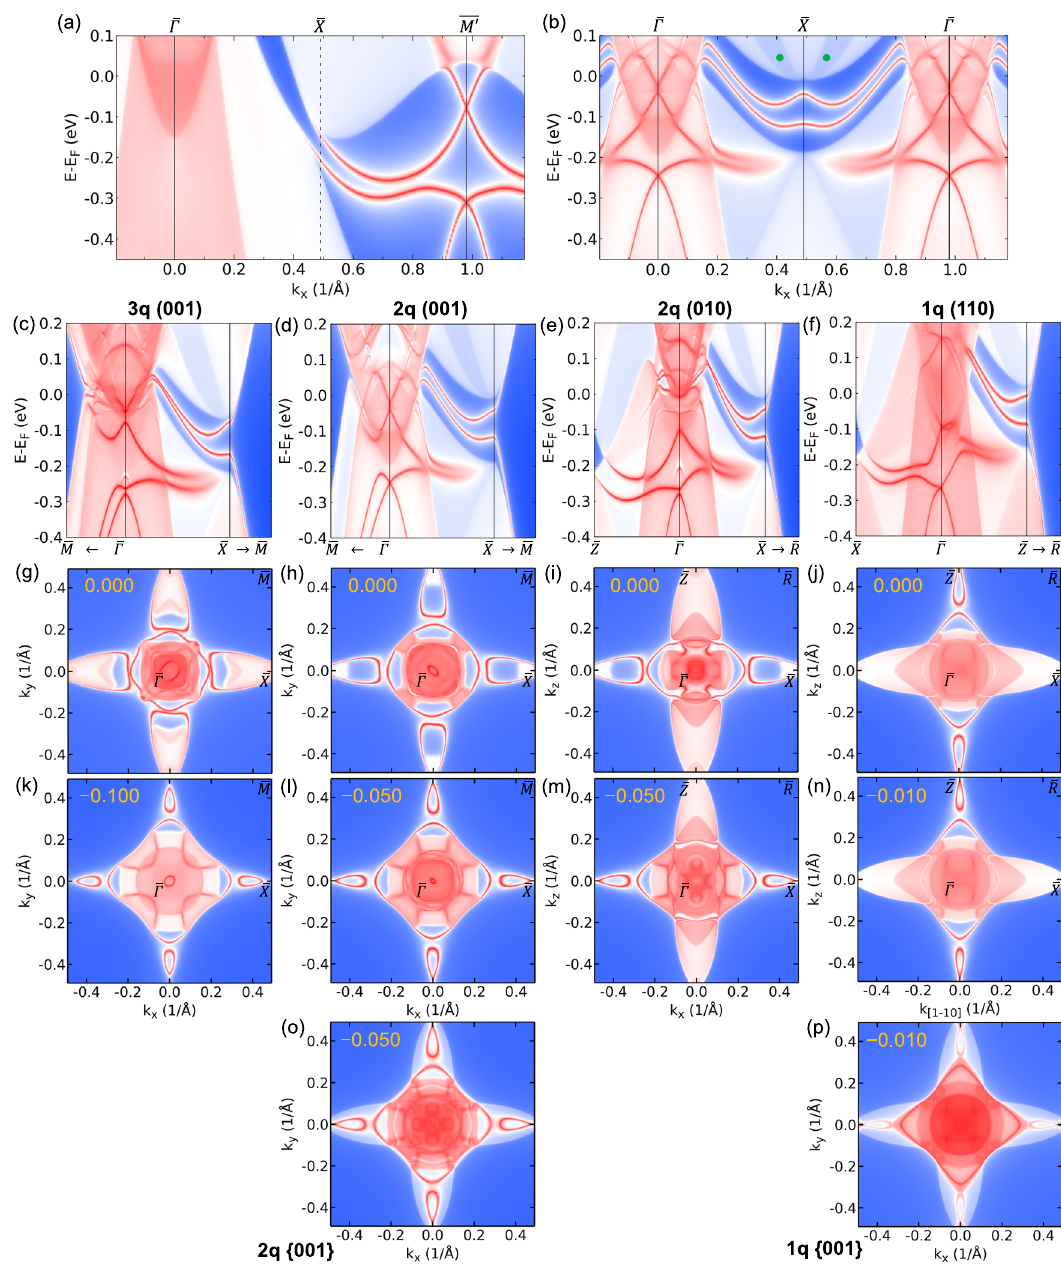
(cid:1) M 0 and ( b ) 2q (001) along the equivalent direction of (cid:1) Γ - (cid:1) X - (cid:1) Γ . The green Fig. 3 Surface spectral functions of NdBi. a nonmagnetic (NM) (001) along (cid:1) Γ - (cid:1) X - dots indicate the original band inversion region along (cid:1) Γ - (cid:1) X , just above the bulk hybridization gap and the associated unconventional surface state pairs. Surface spectral functions on ( c ) 3q (001), ( d ) 2q (001), ( e ) 2q (010) and ( f ) 1q (110) along other directions. 2D surface Fermi surfaces at two different energies as labeled in eV with respect to Fermi energy (E F ) for four surfaces: ( g , k ) for 3q (001), ( h , l ) for 2q (001), ( i , m ) for 2q (010), and ( j , n ) for 1q (110), respectively. ( o , p ) are the averaged cubic {001} domains for 2q and 1q, respectively. Blue, white and red colors stand for low, medium, and high density of